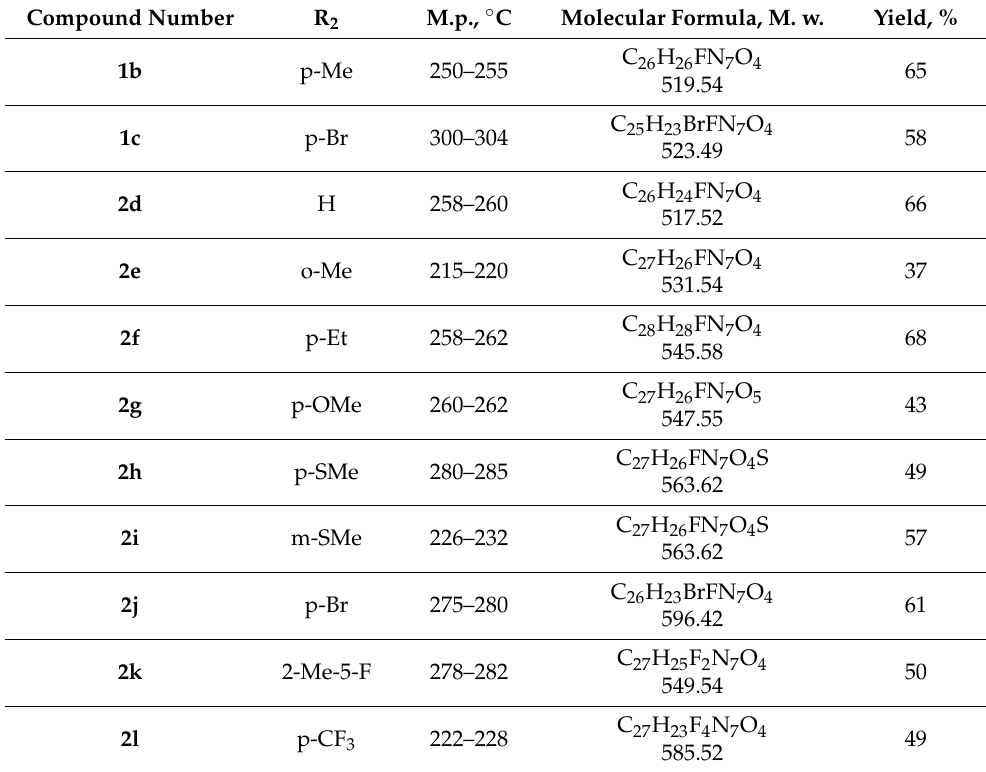
Table 1. Melting points, elemental analyses, and yields for compounds 1b,c , 2d-l